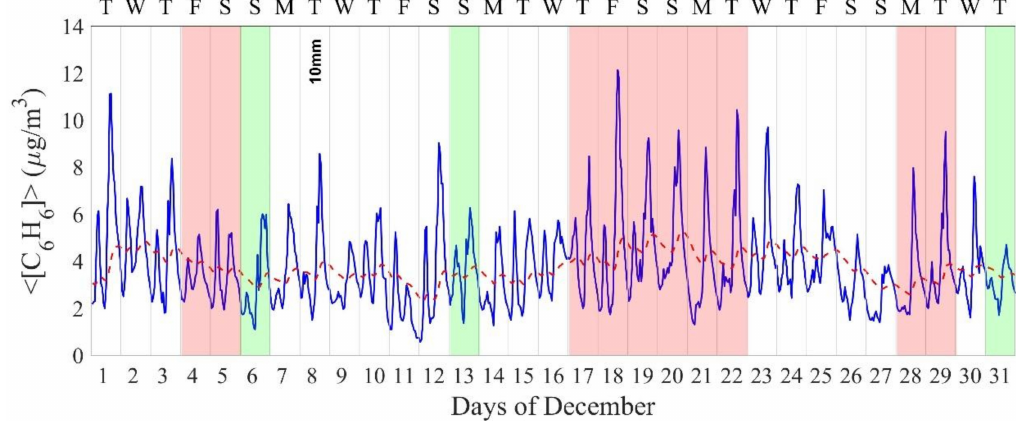
Figure 8. Benzene concentration variation related to the total block of urban traffic (green band) and alternated plates (red band) of December 2015. The blue line is the hourly pollutant concentration. The red dashed line is the daily mean pollutant concentration. Data of daily precipitation are indicated in mm.